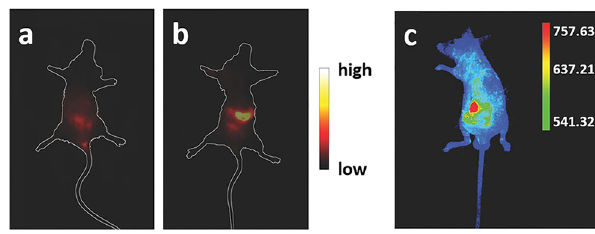
Fig. 3 In vivo fl uorescence imaging capability of RTCDs. In vivo NIR fl uorescence in mouse a before and b after injection with CDs in PVP aqueous solution ( λ ex = 671 nm, λ em = 750 nm). c In vivo fl uorescence image of nude mice subcutaneously injected with RTCDs ( λ ex = 540 nm, λ = 600 nm). The color bars represent the intensity of fl uorescence. (Fig. em 3a, b adapted with permission from ref. 54 , Copyright 2017 Wiley. Figure 3c adapted with permission from ref. 44 , Copyright 2018